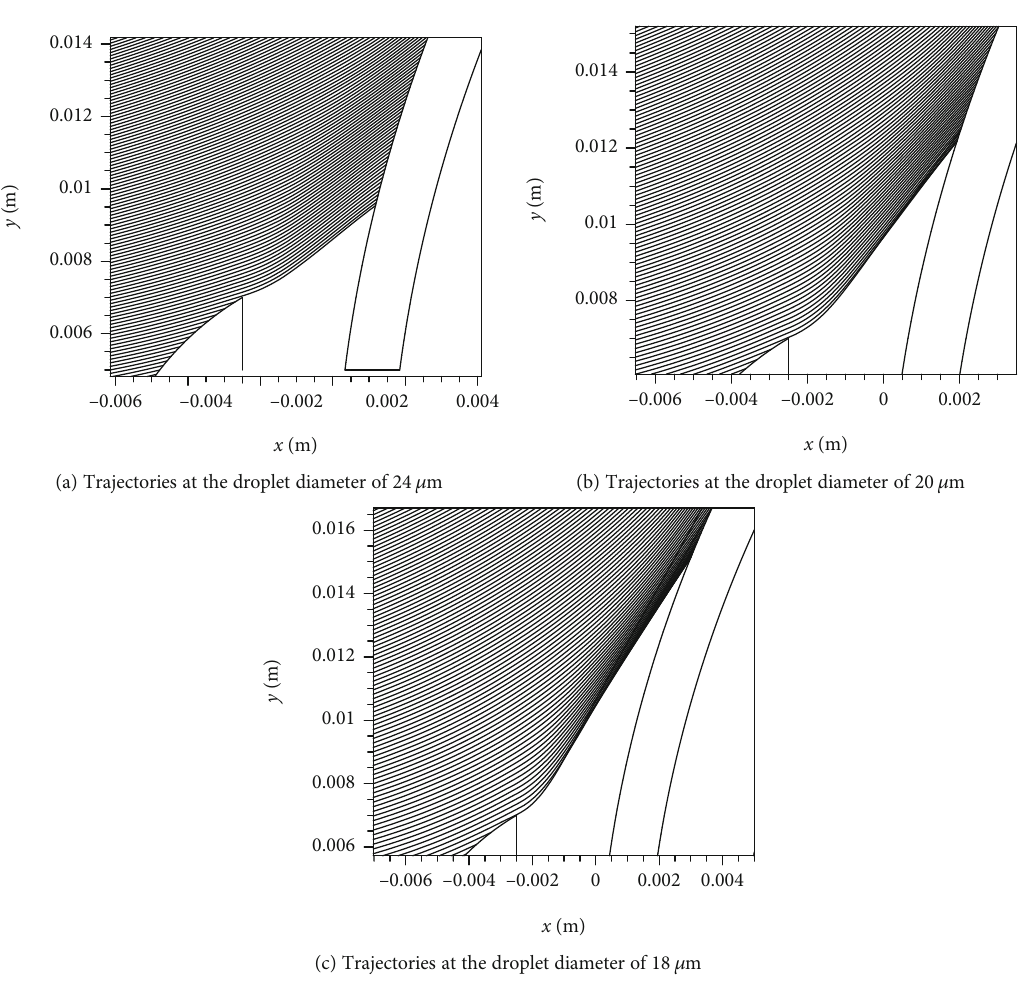
Figure 12: Droplet trajectories for the engine cone section at various droplet diameters.